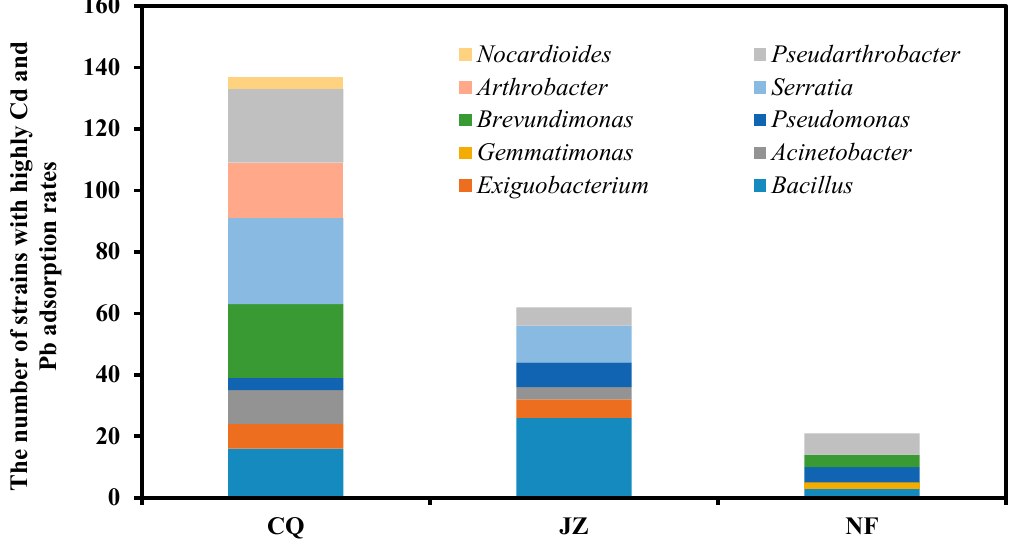
Figure 3. Genus-level di ff erences of the heavy metal-immobilizing bacteria in CQ, JZ, and NF samples. CQ: farmland next to the company area; JZ: farmland near Jiazhuang village 3 km away from the company; NF: farmland near Nanfan village 6 km away from the company.